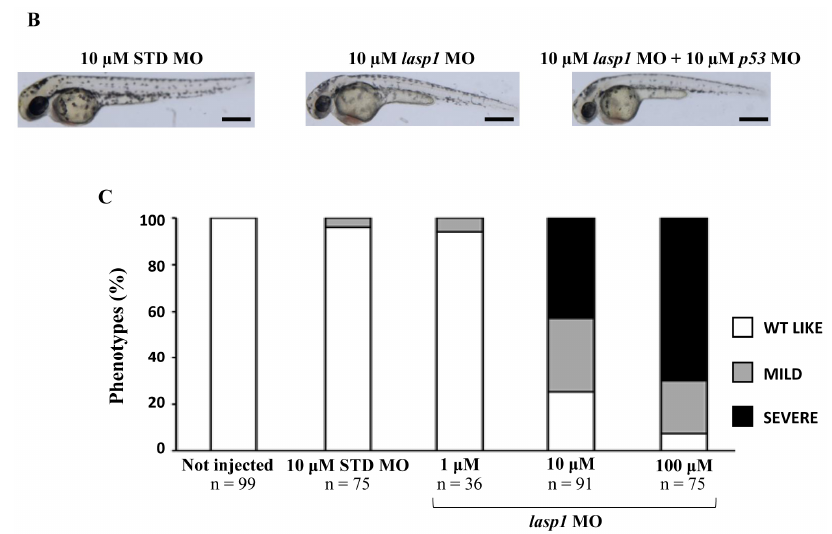
Figure 3. The evaluation of the morphological defects in lasp1 MO morphants. ( A ) Representative images of the phenotypes of zebrafish embryos injected with 10 µM control morpholino (STD MO) or 10 µM lasp1 MO and photographed at 48 hpf. Morphants exhibited different morphological defects, including the severe phenotype with underdeveloped body and heart edema ( a ); undeveloped eyes and reduced tail size ( b ); and the mild phenotype with reduced head size, hypopigmentation and thick yolk extension ( c ). ( B ) No differences were observed between embryos injected with lasp1 -MO alone and those injected with the combination of lasp 1 MO and p53 MO. Scale bars: 200 µm. ( C ) Analysis of morphological phenotypes in lasp1 MO morphants revealed developmental defects. Most of the 10 µM and 100 µM lasp1 1 MO morphants revealed mild or severe phenotypes; the ST MO and the 1 µM lasp1 MO morphants mainly showed the wild-type phenotype. The number under each bar is the total number of embryos examined under each experimental condition. Three biological replicates were used for each assay.